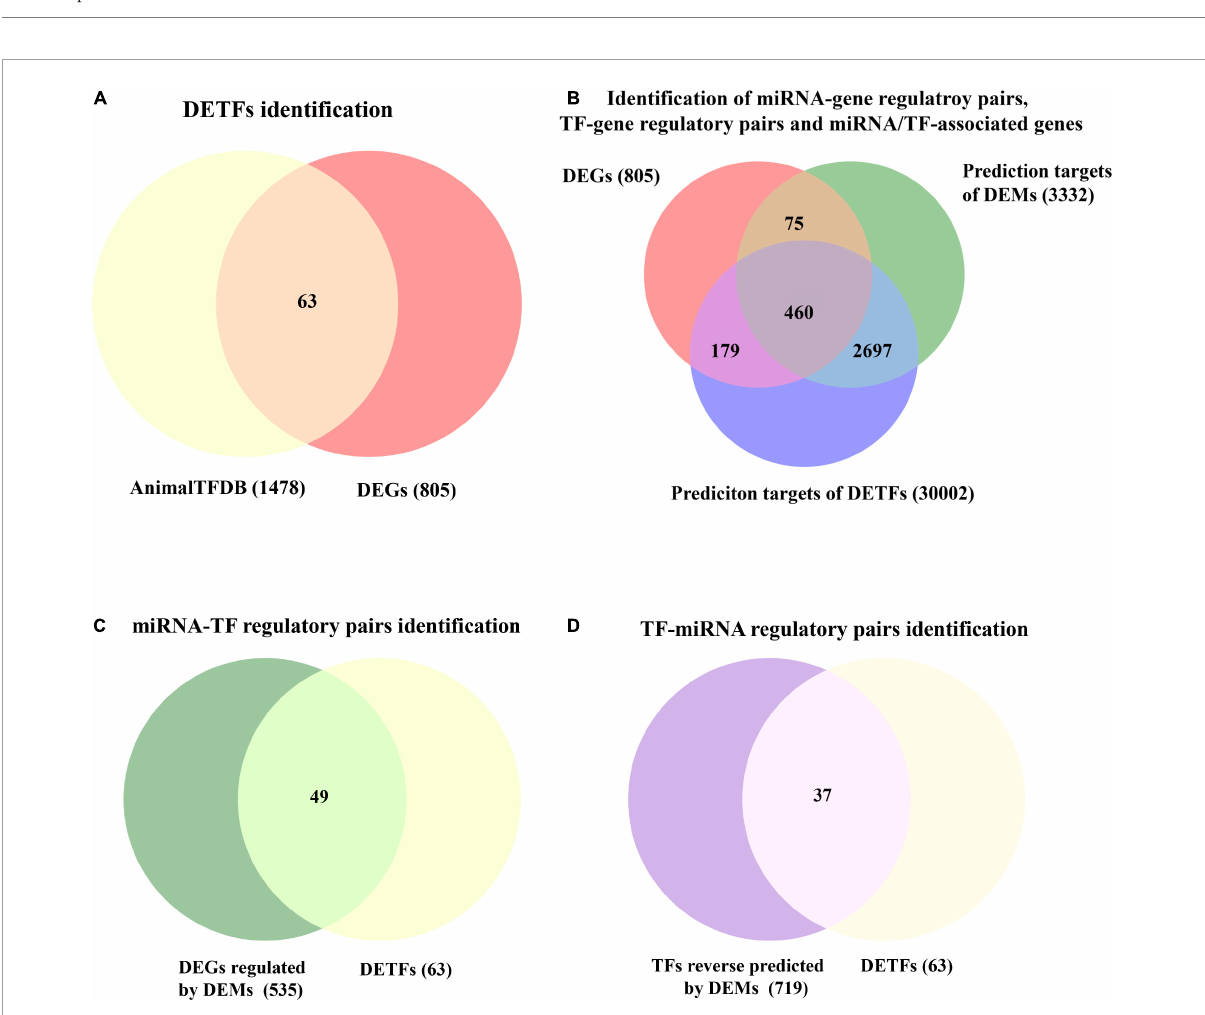
FIGURE4 Identification of DETFs and DEGs jointly regulated by DEMs and DETFs. (A) Identification of 63 DETFs from DEGs using the Venn diagram. (B) Target prediction of DEMs and DETFs. A total of 535 miRNA-gene regulatory pairs, 639 TF-gene regulatory pairs, and 460 miRNA/TF-associated DEGs are identified. (C) Identification of 49 miRNA-TF regulatory pairs in total. (D) Identification of 37 TF-miRNA regulatory